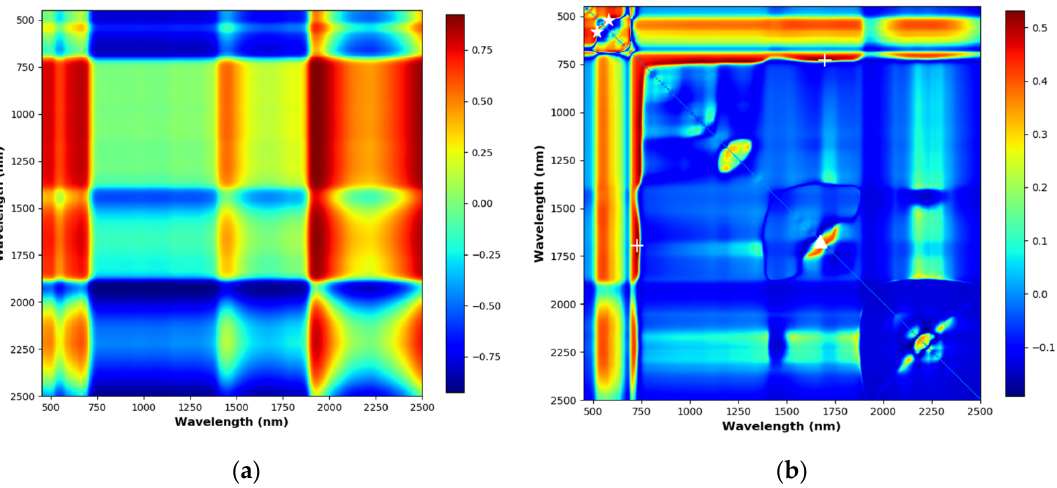
Figure 6. NDVI and R 2 matrices. The different colour indicating the different values of NDVI or R 2 . ( a ) An NDVI matrix showing all possible wavelength combinations of a reflectance data from the ASD FieldSepc 3. ( b ) The R 2 matrix of NDVI for validating the PLSR models.